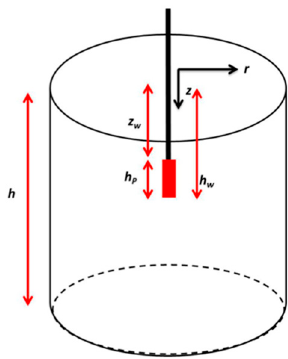
Figure 1. Problem in cylindrical coordinates .